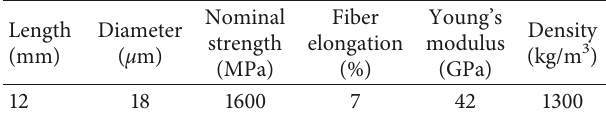
Figure 1: Three-point bending specimen’s geometry and di- mensions (mm). Table 1: Properties of the PVA fiber.